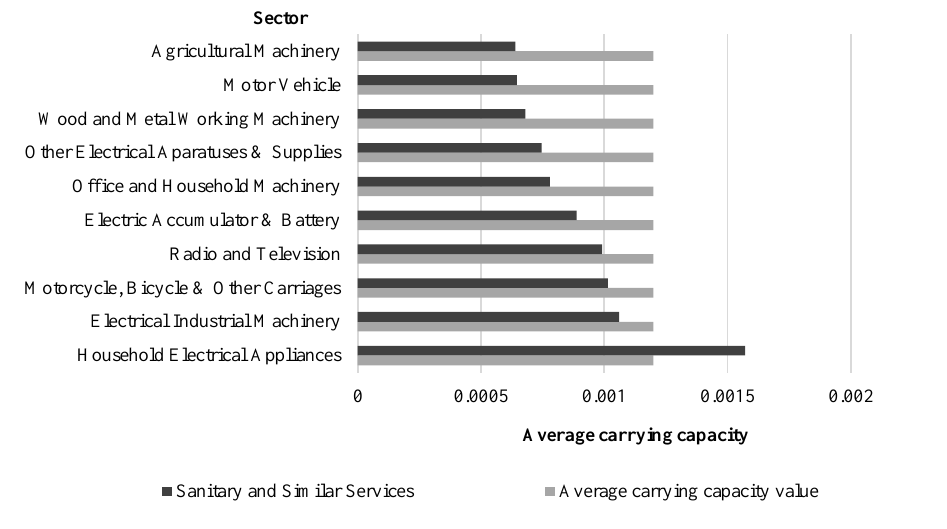
Fig. 6. Sanitary and Similar Services